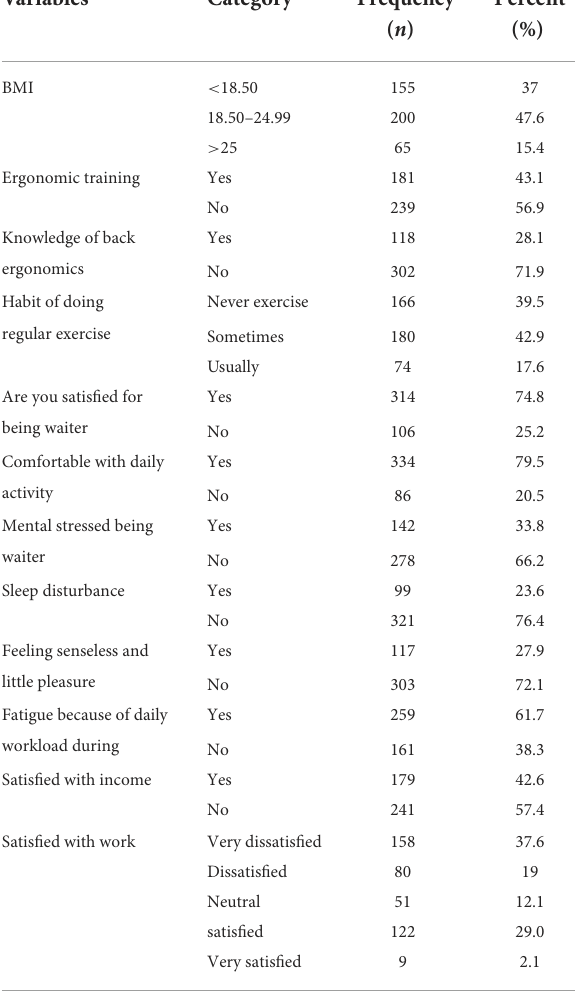
TABLE 3 Occupational and ergonomics factors of restaurant wait staff in Gondar town, Ethiopia, 2019 ( n =